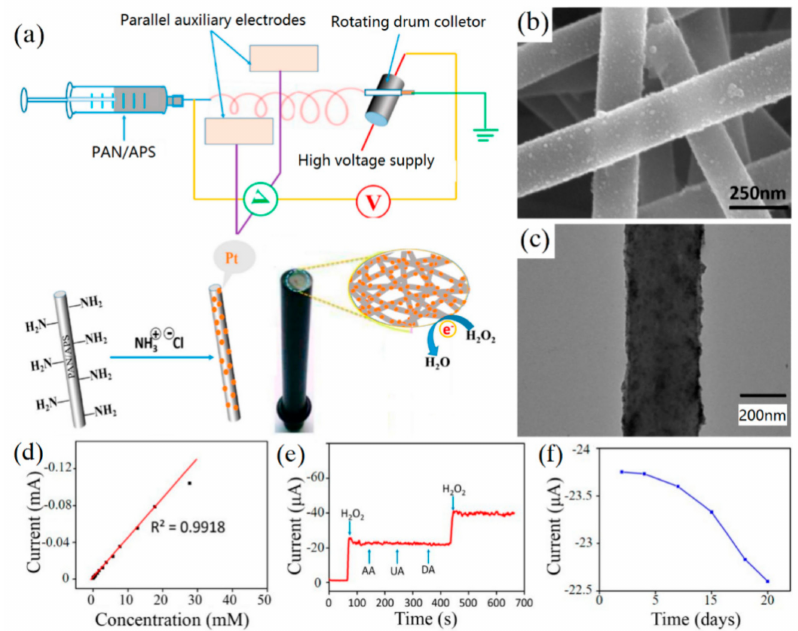
Figure 7. ( a ) Schematic of electrospinning apparatus for the fabrication of PAN / APS composite nanofibers; ( b ) SEM image of PAN / PtNPs composite nanofibers; ( c ) TEM images of electrospun PAN / PtNPs; ( d ) corresponding linear relationship between concentration and current; ( e ) selectivity of the sensor; ( f ) stability of the sensor. (reproduced with permission from reference